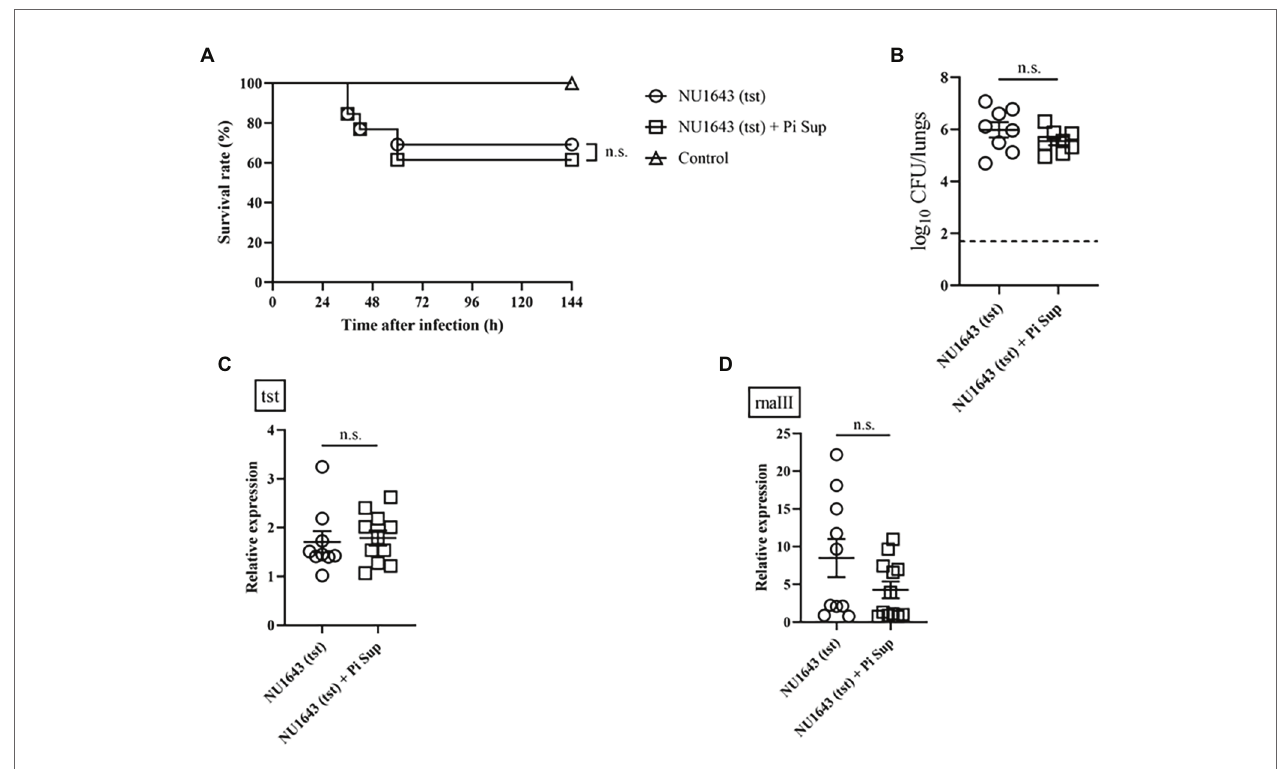
FIGURE 4 | (A) Survival rates and (B) bacterial loads of mice infected with the NU1643 TSST-producing MRSA strain with/without Pi Sup. O , NU1643-infected mice without Pi Sup; ◽ , NU1643-infected mice with Pi Sup; and △ , broth-inoculated mice. Bars represent mean bacterial counts, n = 6–12 mice/group. The broken horizontal line represents the lower limit of detection (1.7 log10 CFU/ml of lung specimen). Similar results were obtained from two independent experiments. Transcript levels of (C) tst and (D) rnaIII measured 16 h after inoculation in mice infected with NU1643 MRSA with/without Pi Sup. Bars represent the mean relative mRNA expression. Data are representative of 5–8 mice from two independent experiments. n.s., not